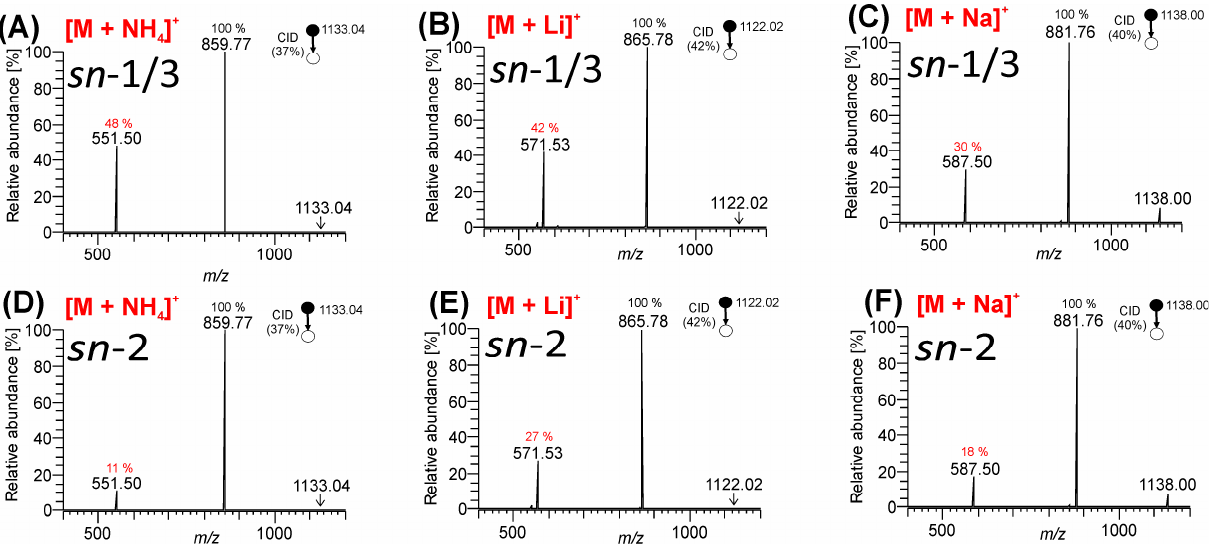
Figure 6. MS 2 CID spectra of TG ‐ EST glycerol sn ‐ regioisomers. Variable molecular adducts of TG ‐ EST 7 ( sn ‐ 1/3) were fragmented: ( A ) [M + NH 4 ] + ; ( B ) [M + Li] + ; and ( C ) [M + Na] + . Variable adducts of TG ‐ EST 8 ( sn ‐ 2) were fragmented: ( D ) [M + NH 4 ] + ; ( E ) [M + Li] + ; and ( F ) [M + Na] + . Values of relative abundance ratios of fragments were described.